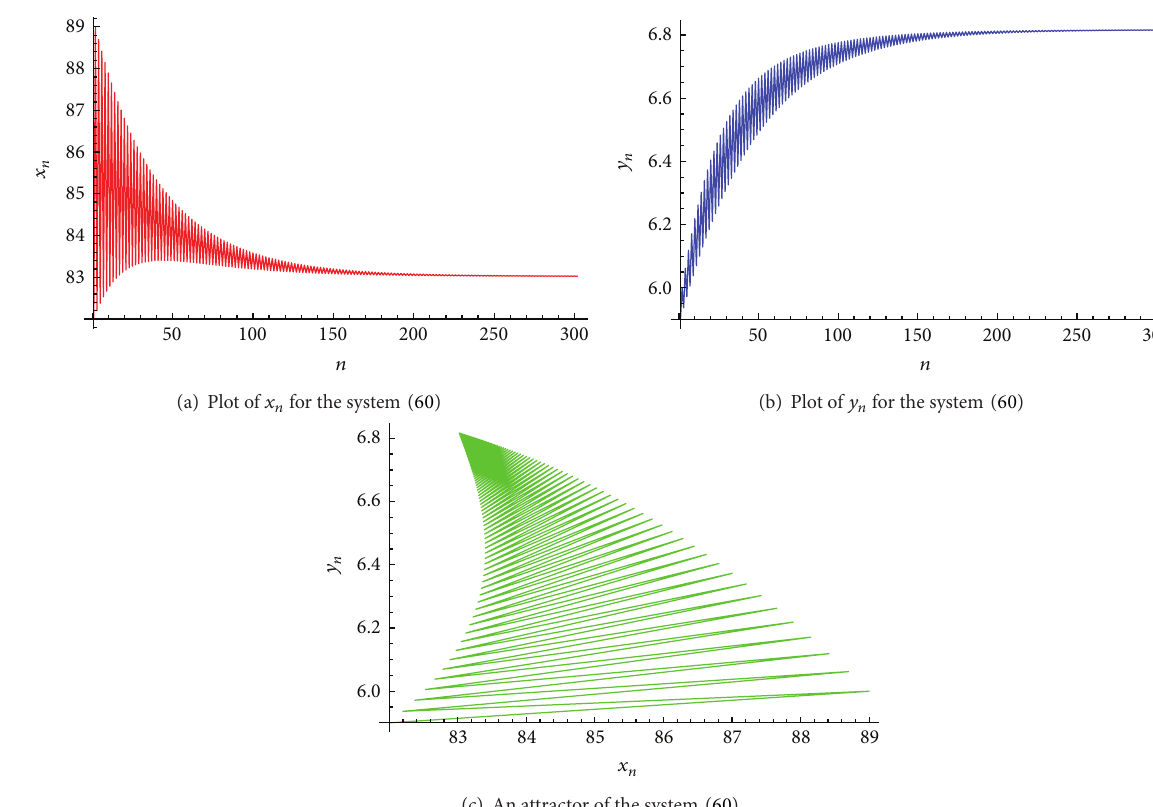
Figure 2: Plots for the system (60).